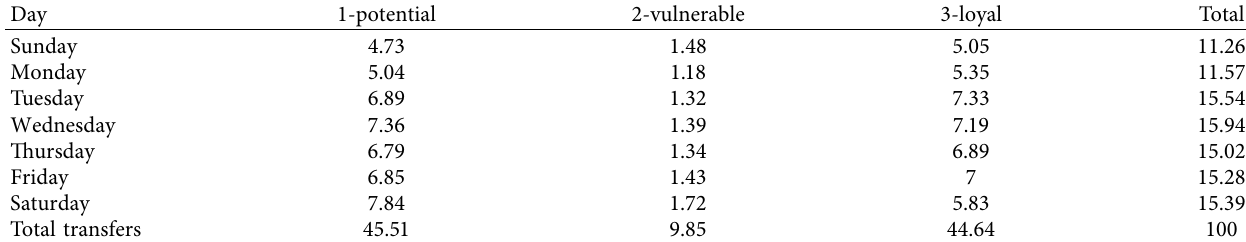
Table 17: % daily transfer distribution among target segments ( K � 3) in 2019.